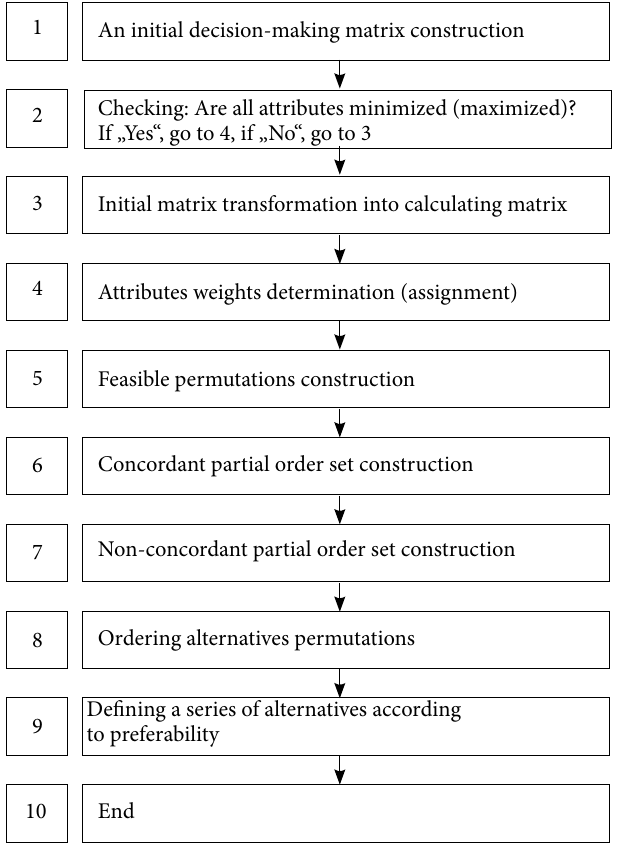
Fig. 2. Block-diagram of ordering feasible alternative solutions according to